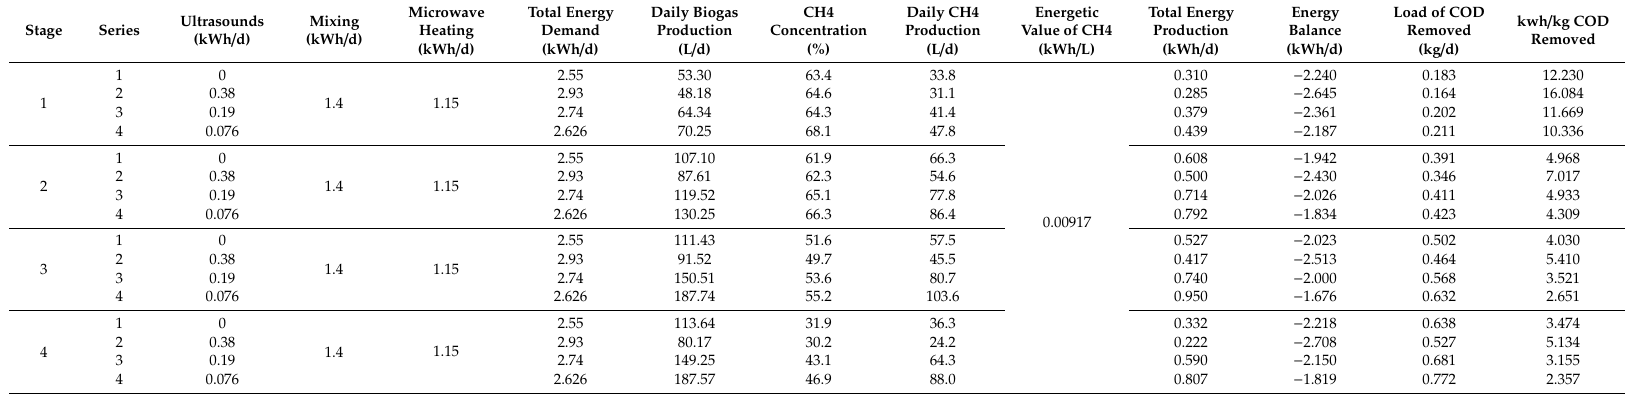
Table 5. Energy balance of wastewater treatment in